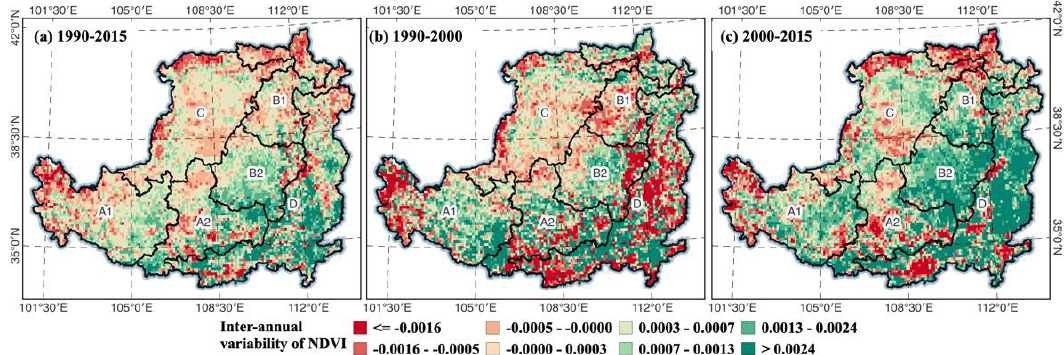
Figure 2. Annual NDVI trend in the LP, 1990-2015 ( a ), 1990-2000 ( b ), 2000-2015 ( c